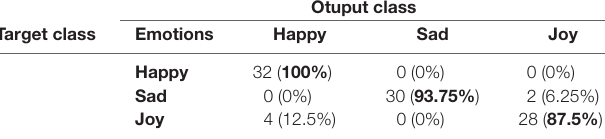
TABLE 6 | Confusion matrix for three emotional states.